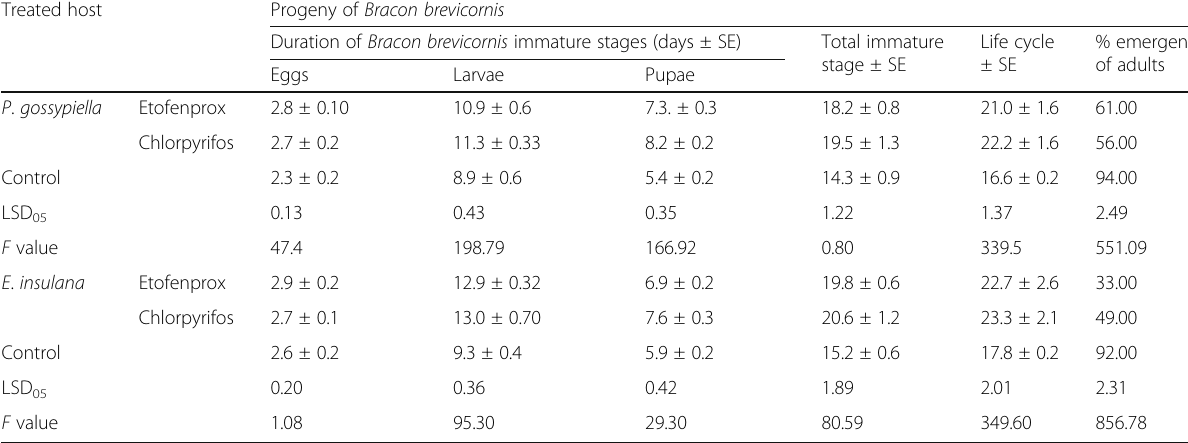
Table 3 Indirect effect of tested compounds on progeny (immature stage) of Bracon brevicornis reared on full-grown larvae of P. gossypiella and E. insulana treated as newly hatched larvae Treated host